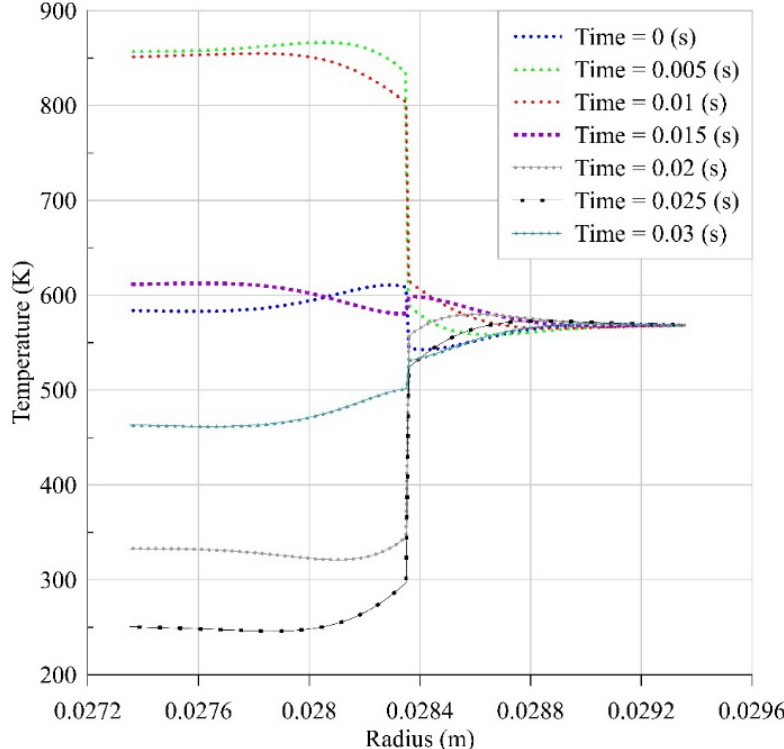
Figure 8. Flow temperature in the gap = 10 μm.